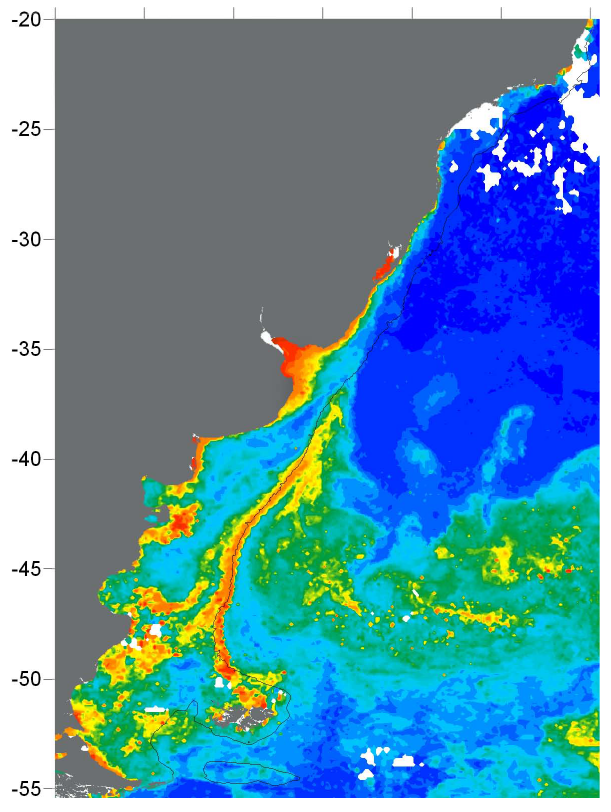
Fig. 8. SeaWiFS derived surface chlorophyll distribution averaged between 17–24 January 2009 in the southwestern Atlantic region.